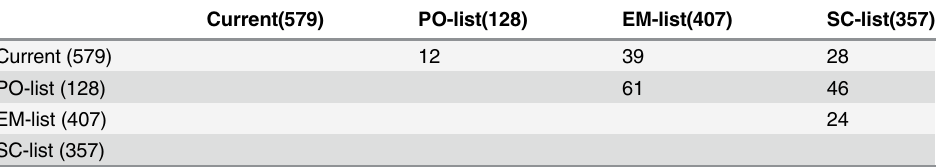
Table 1. The overlapping among EMT generic signature